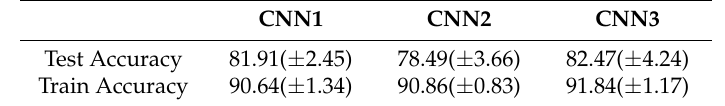
Table 5. Average classification accuracy across in 4-fold stratified cross-validation.